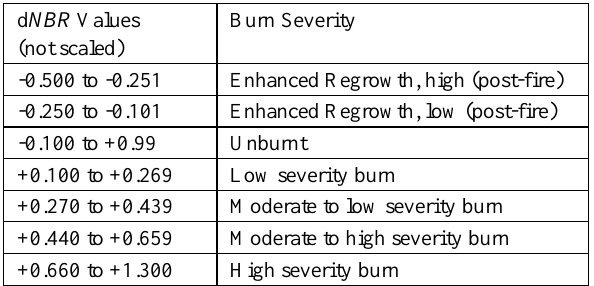
Table 1. Burn severity levels obtained calculating d NBR , proposed by United States Geological Survey (USGS).